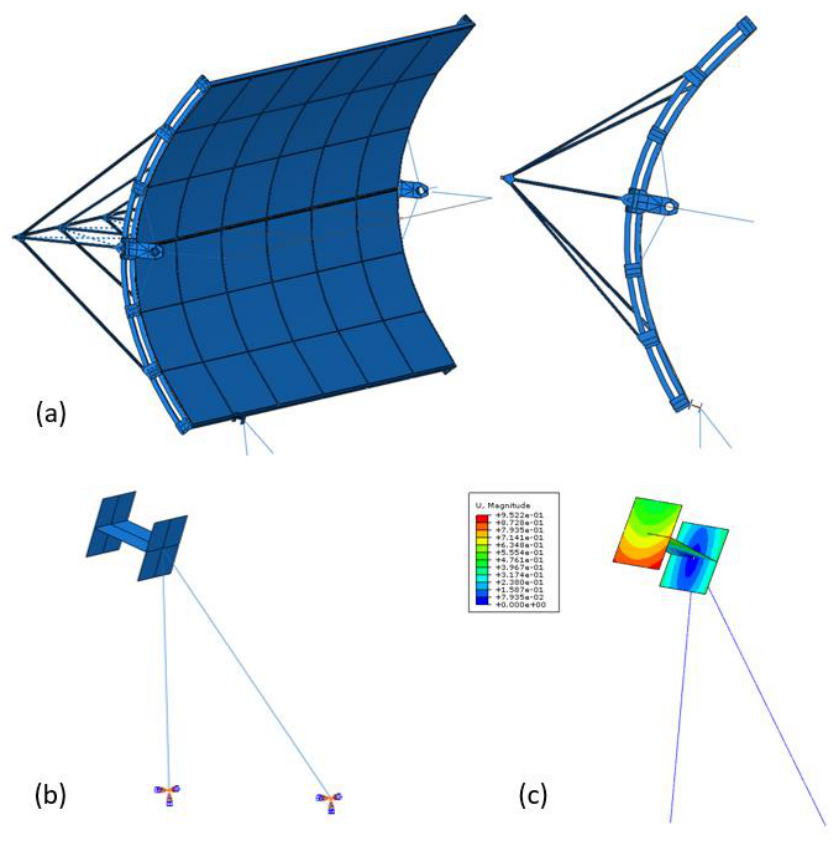
Figure 14. ( a ) Numerical model of the concentrated bending; ( b ) encastre applied on the contrast structure; ( c ) contours of the displacement magnitude of the contrast structure when the maximum load is applied.